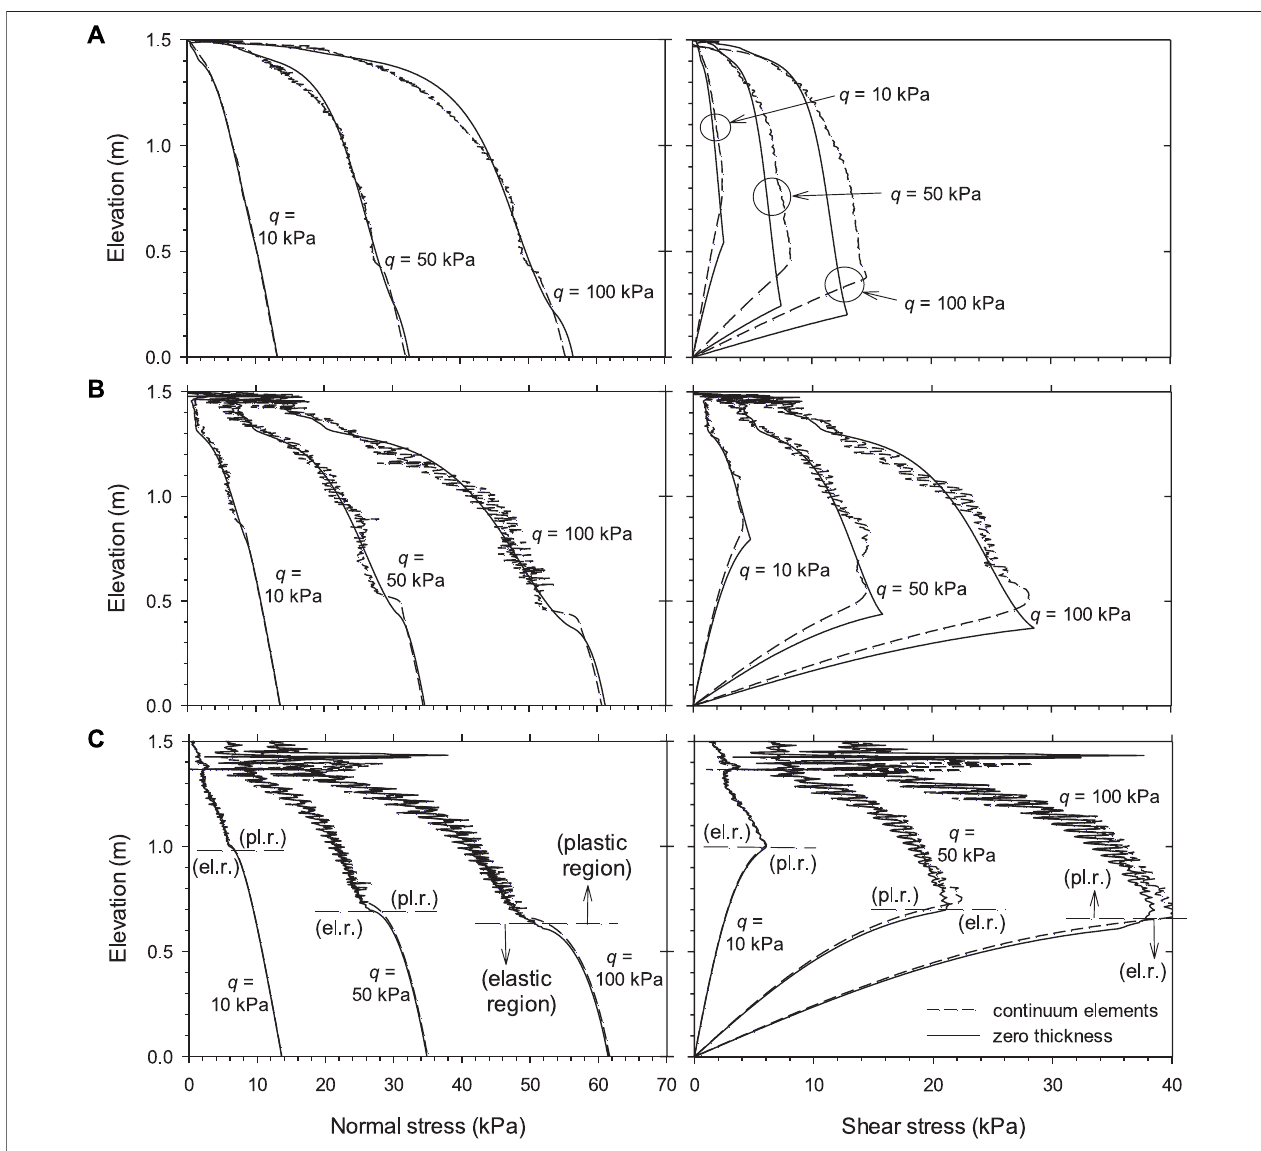
FIGURE 4 | Load transfer from back fi ll soil to facing panel using PLAXIS: normal and shear stresses at the interface between facing structure and back fi ll soil with optimized mesh for three different strength/stiffness reduction factors: (A) Ri = 0.3, (B) Ri = 0.6, and (C) Ri = 1.0 (Damians et al. 2015b).